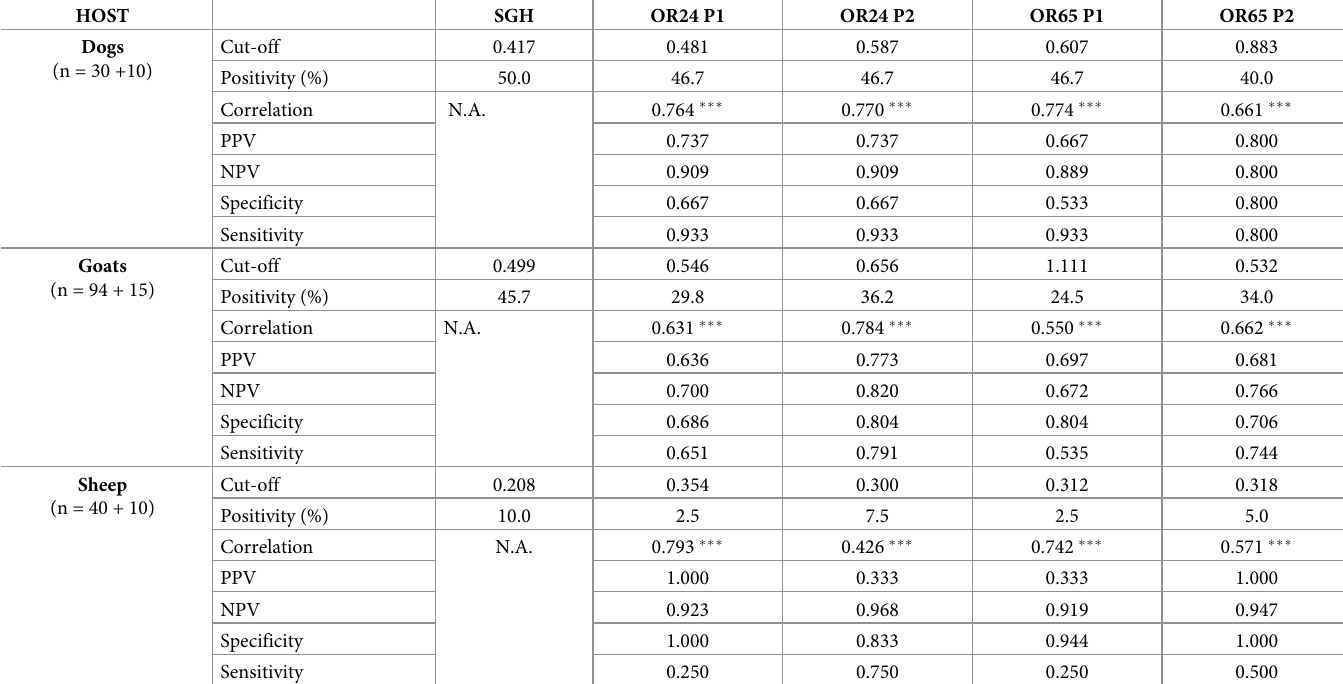
Table 2. Evaluation of peptides in ELISA experiments.